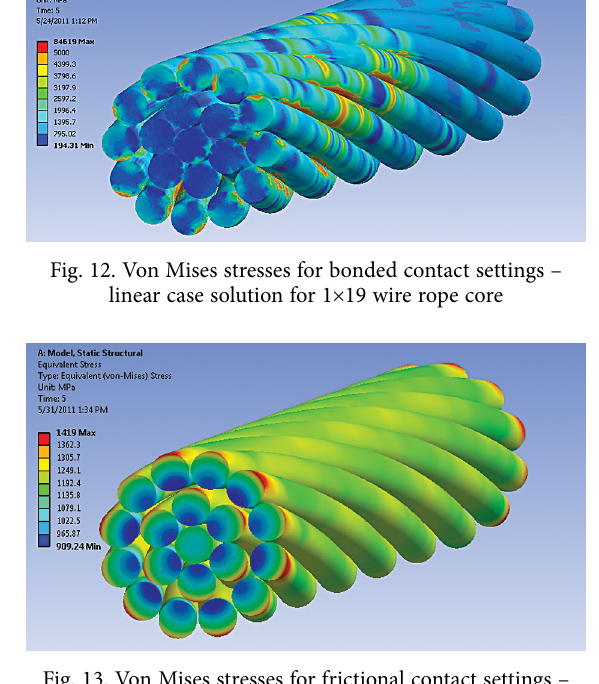
Fig. 13. Von Mises stresses for frictional contact settings – nonlinear case solution for 1 × 19 wire rope core